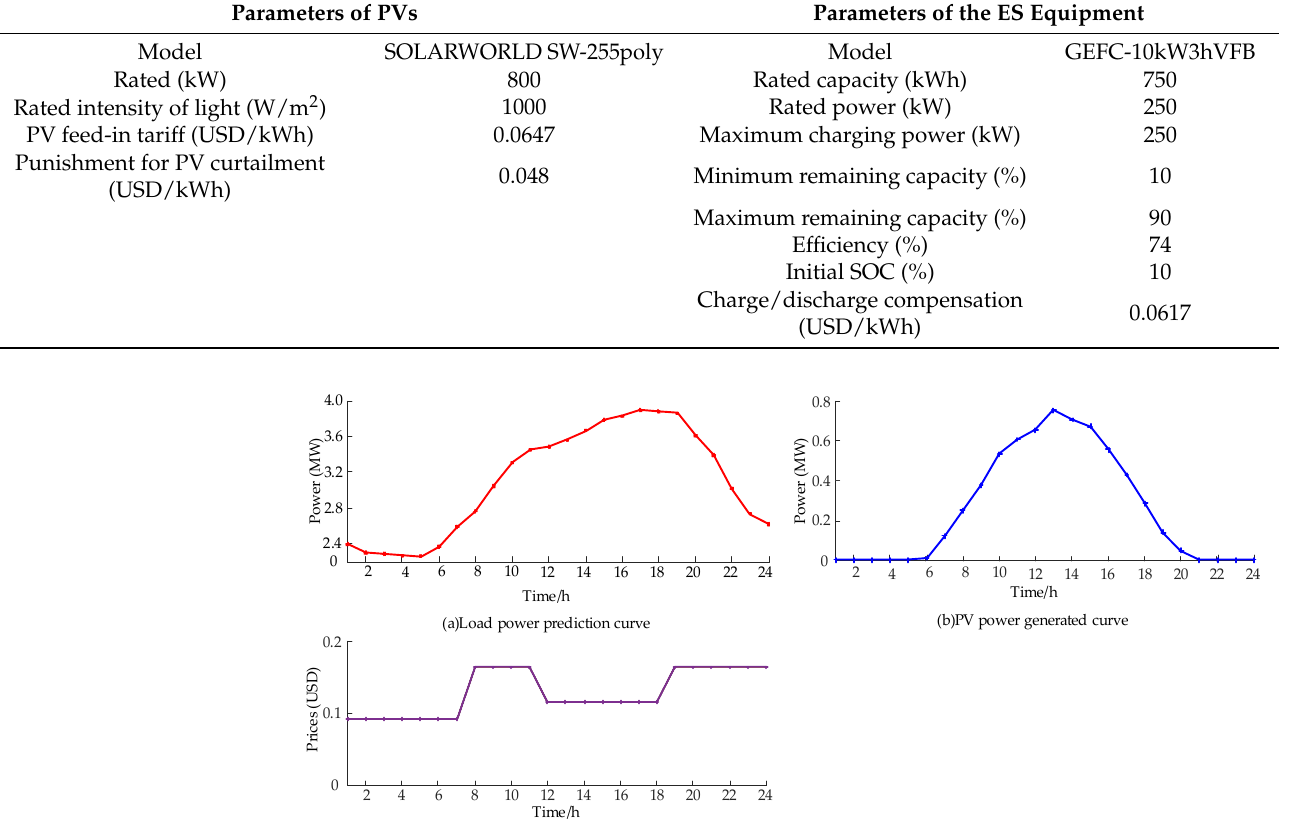
(c) Prices of electricity curve Figure 5. Power prediction for PV and loads and power purchasing price curves .